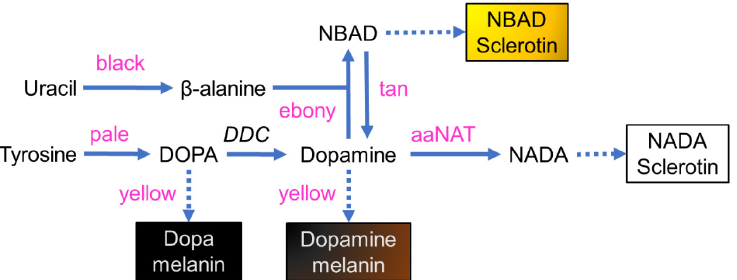
Figure 1. Model of melanin and sclerotin biosynthesis in insect cuticles. Tyrosine is converted by tyrosine hydroxylase (pale) to DOPA, which in turn can be transformed by DDC into dopamine. DOPA and dopamine can be converted into brown and black melanins through several intermediate steps that are promoted by yellow. Dopamine also can be converted by synthases into colorless or yellow sclerotin pigments. Production of clear NADA sclerotins is catalyzed by aaNAT. Production of the yellow to tan NBAD sclerotin is promoted by ebony and black, but its reversion is promoted by tan. Adapted from [17,26].